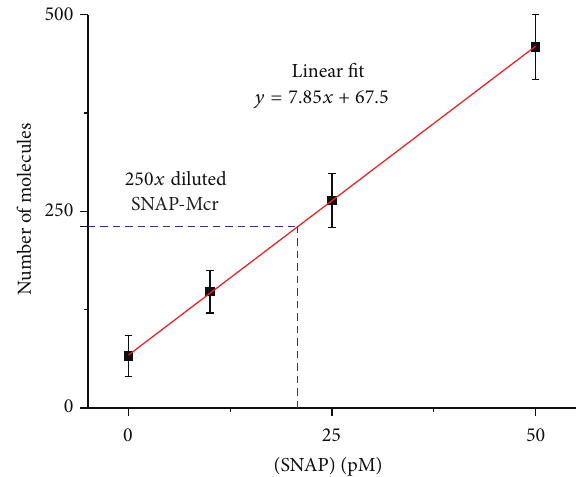
Figure 8: Calibration curve for SiMPull experiments that provides a mapping between protein concentration in cell lysate and number of spots observed on the